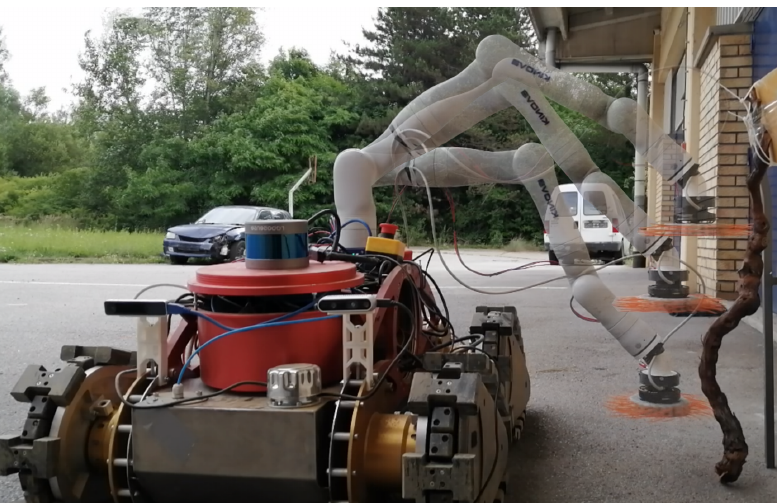
Figure 8. Trunk following experiment. Compliant control in forward direction from Section 4 is used, while the tool follows a sinusoidal function in the vertical